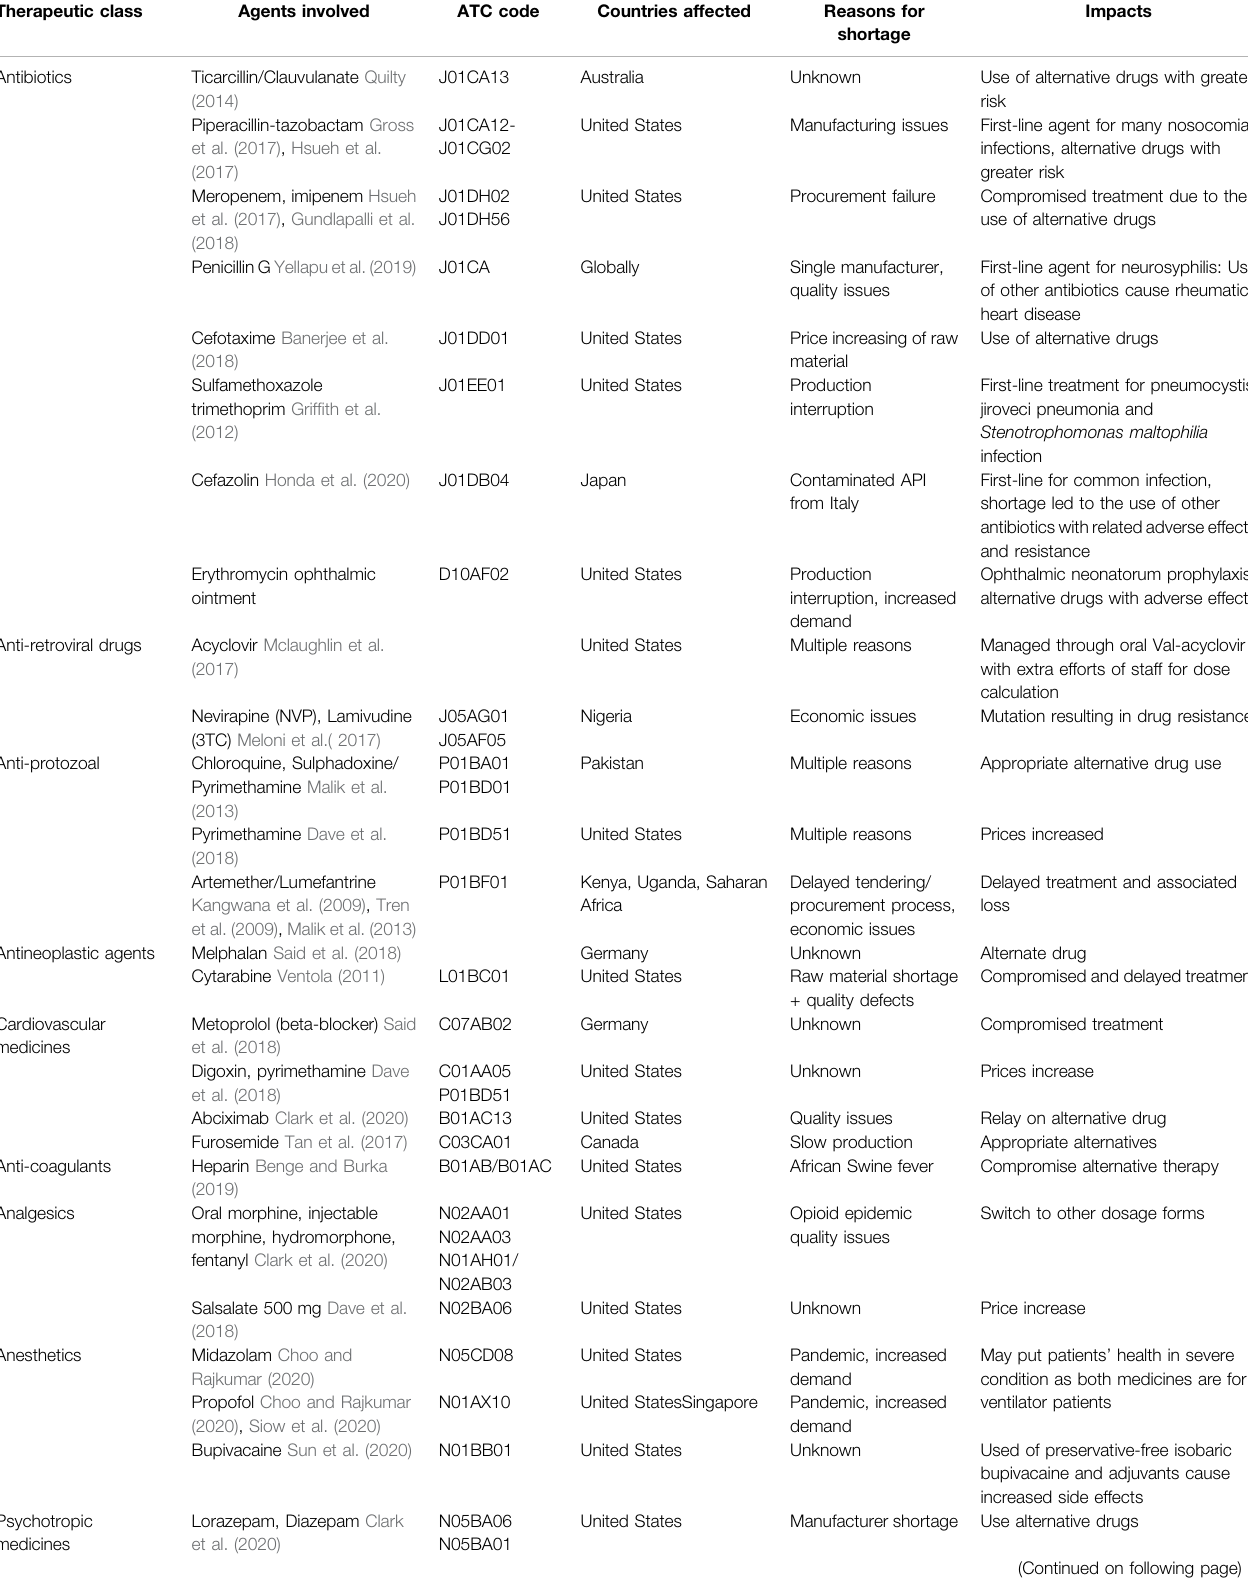
TABLE 1 | Medicines involved in